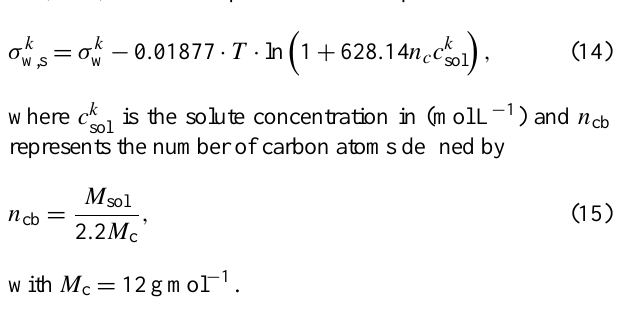
Figure 3. Sparse structure of Jacobian for two droplet classes (adapted from Wolke et al.,